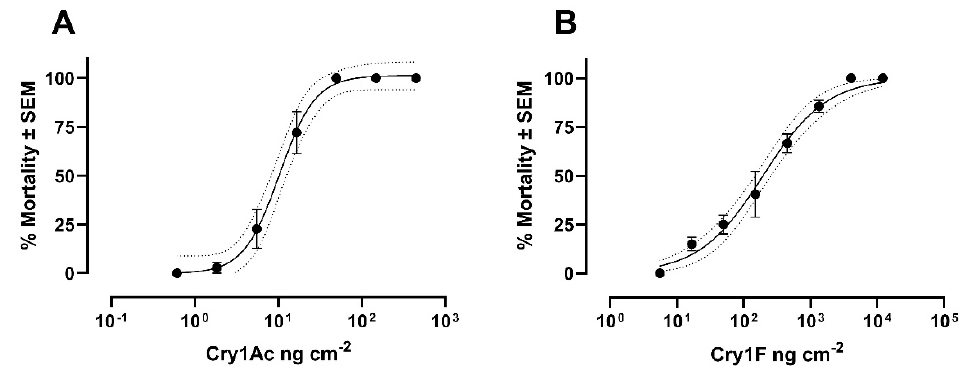
Figure 1. Toxicity of Bt proteins against neonates of soybean looper strain SBL-Benzon. (A) Toxicity of Cry1Ac (N = 288) and (B) toxicity of Cry1F (N = 324). Dashed lines indicate the 95% confidence band. Table 1. Stability analysis of the candidate reference genes ribosomal protein L10 ( RPL10 ), glyceraldehyde- 3-phosphate dehydrogenase ( GAPDH ), elongation factor-1 alpha ( EF1 ), and beta actin 1 ( ACT1 ) analyzed by geNorm (average expression stability or M value) and NormFinder (stability value) in different larval stages of Chrysodeixis includens .